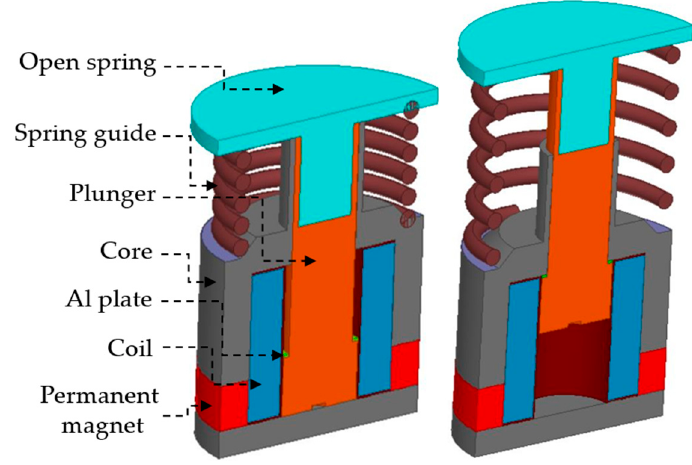
Figure 4. The proposed PMA-type one-coil actuator.